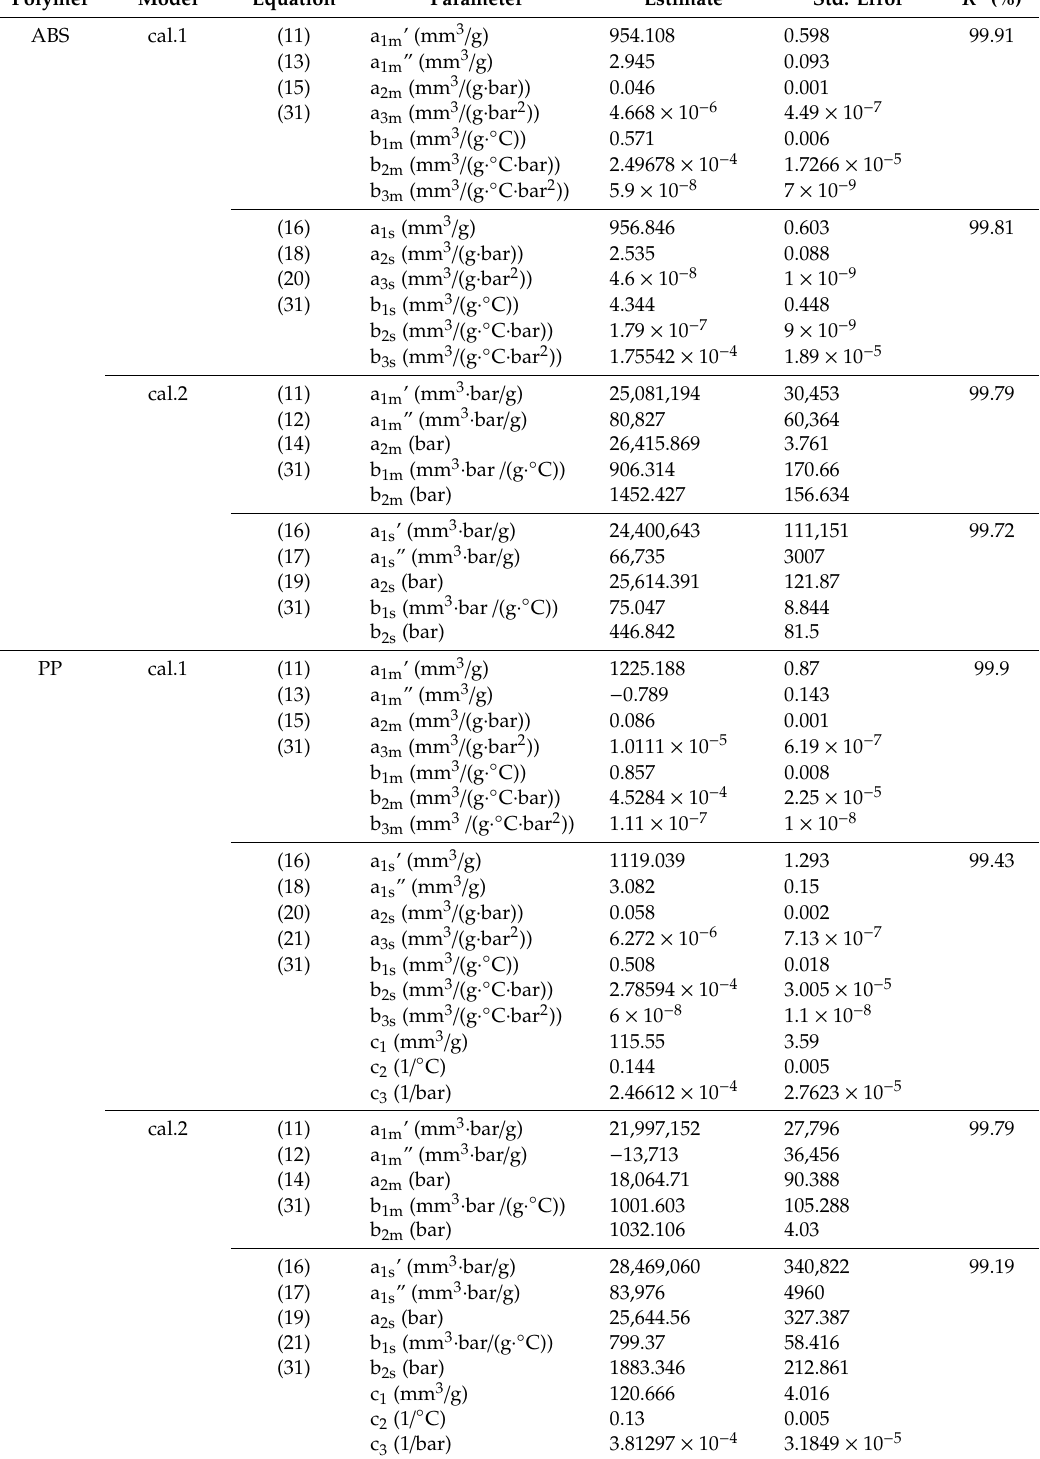
Table 4. Parameters estimated by the discontinuous two-domain EoS considering the cooling rate. Polymer Model Equation Parameter Estimate ABS